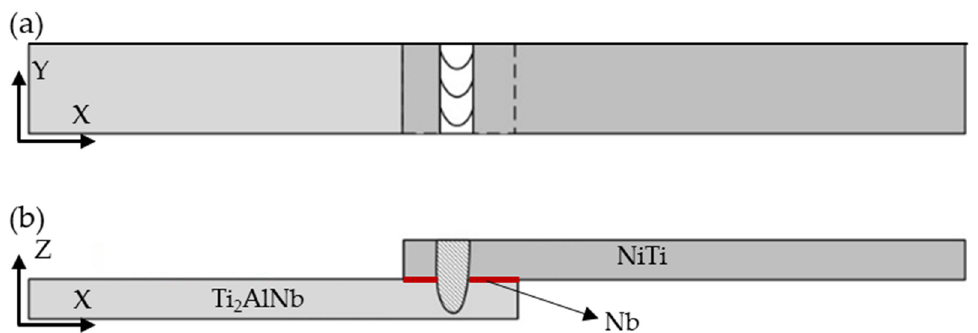
Figure 1. Schematic diagram of lap test: ( a ) Welded specimen in the X-Y plane; ( b ) Welded specimen in the X-Z plane. Table 1. Laser welding parameters. Experiment No.